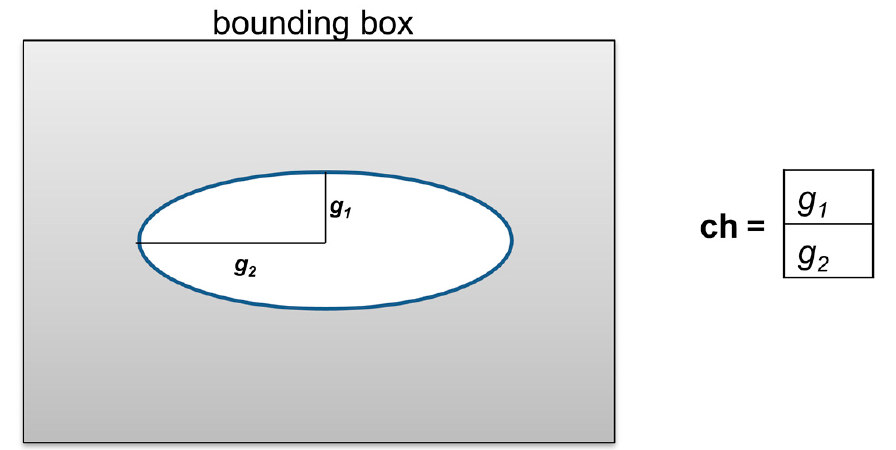
Figure 1. The nanostructure with an elliptical void described by two design variables. The 2D infinite nanostructure was modeled using periodic boundary conditions, and the maximum size of the void was defined by the unit cell size used in simulations. The mechanical properties (stiffness in two directions) were computed using the MD approach. The algorithm for determining the stiffness of the nanostructure is shown in Figure 2. First, the void was introduced into the pristine 2D nanostructure. Next, relaxation was performed, and the stress–strain curve was obtained in two directions during uniaxial tensile load. In general, other loads can be applied to obtain, for example, shear stresses or thermal and optical properties of the